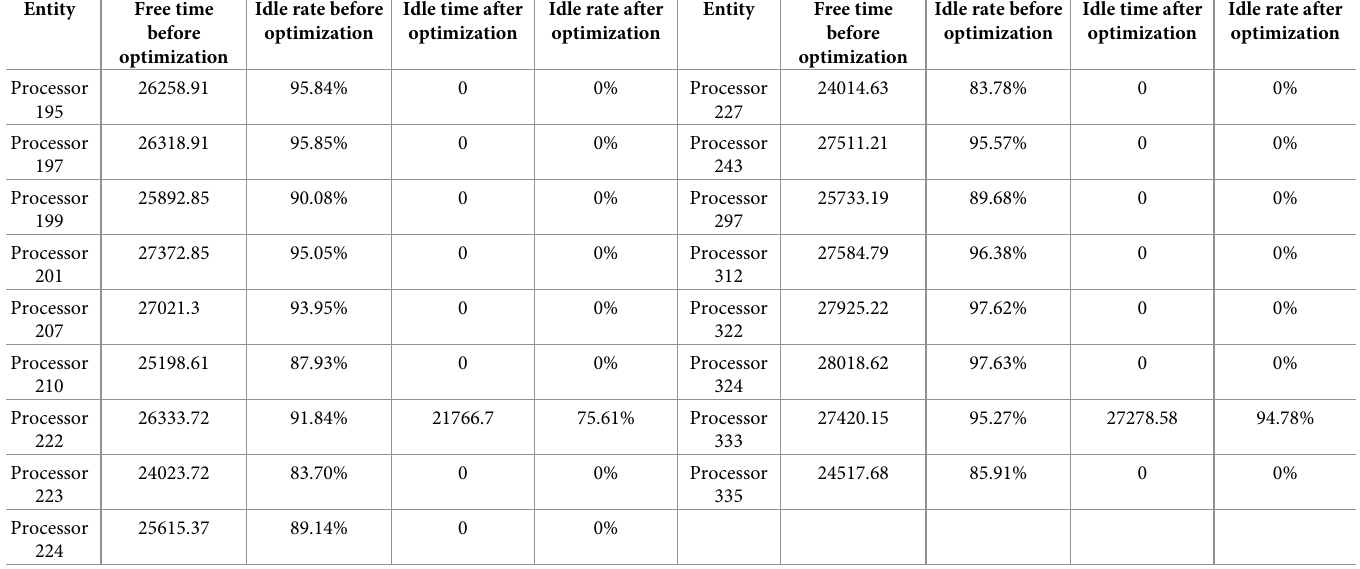
Table 10. Comparison of equipment idle rates before and after